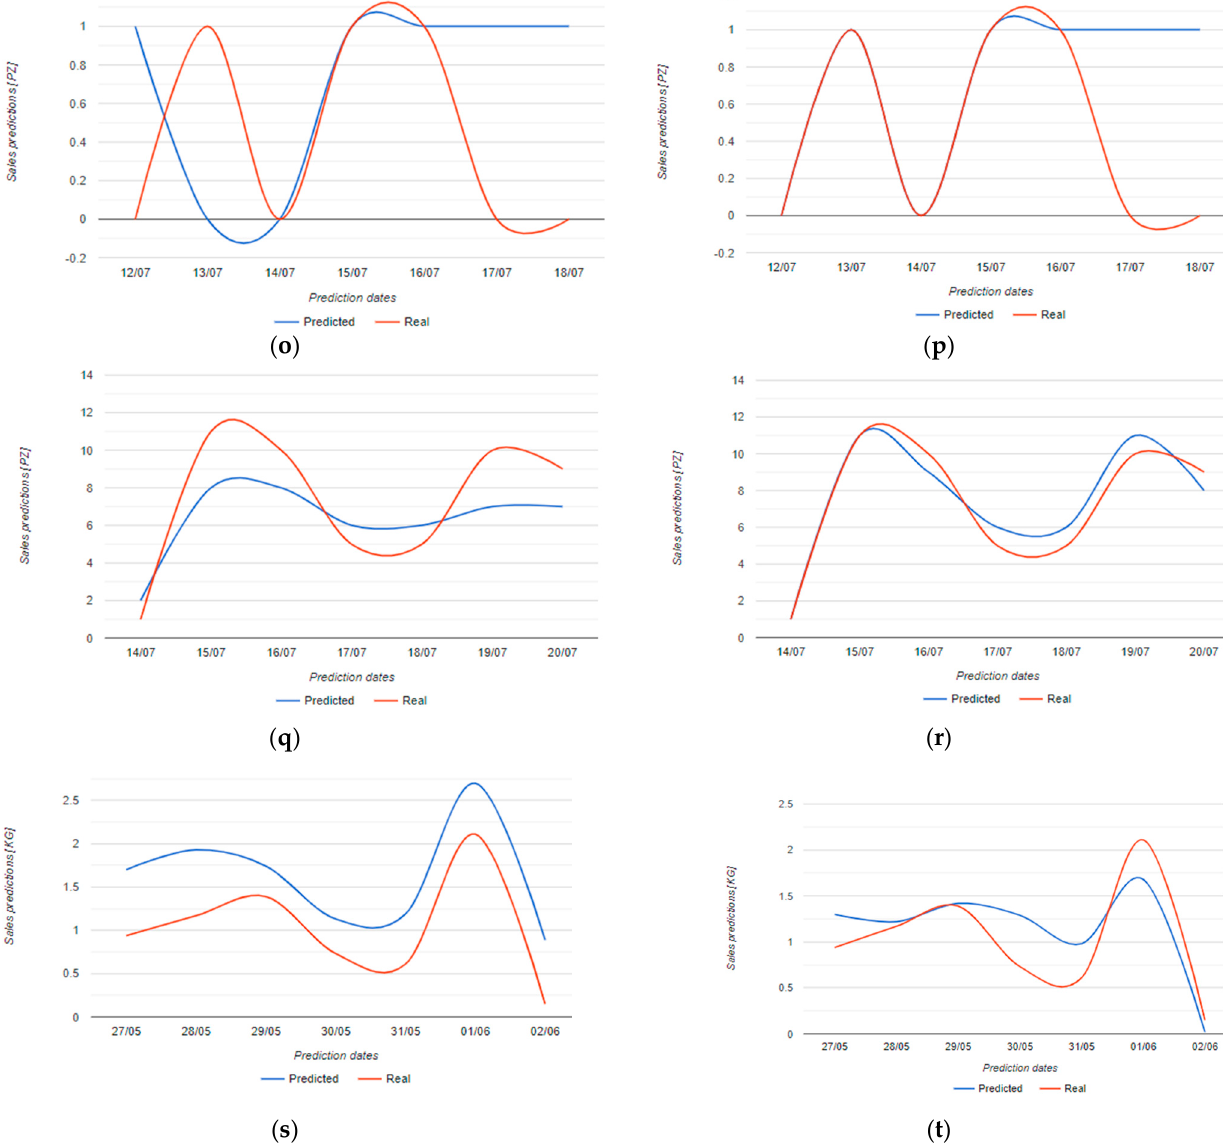
Figure 12. Predictions obtained for different items in the inventory for time intervals lasting 7 days by using original data (left) and augmented data (right): cream pack ( a , b ), paper towel ( c , d ), flour pack ( e , f ), still water bottle ( g , h ), iodized sea salt pack ( i , j ), loose tomatoes ( k , l ), mozzarella in the delicatessen department ( m , n ), frozen soup ( o , p ), bottle of fresh milk ( q , r ), and smoked scarmorze ( s , t ). Table 4. Accuracy (RMSE and RMSEP) results of the XGBoost model when trained with original or augmented data for various items.